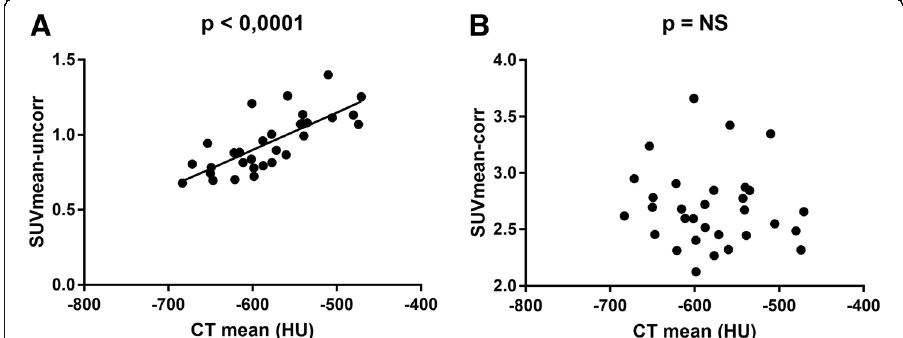
Fig. 2 Correlation between SUVmean and the lung density. The SUVmean (SUVmean-uncorr) ( a ) and the SUVmean corrected for the tissue fraction (SUVmean-corr) ( b ) were calculated and correlated to the mean density assessed by the CT scan (CTmean). n = 31. HU = Hounsfield Unit. NS = not significant